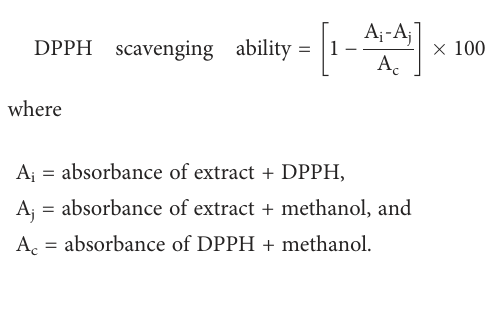
(using soil substrate) under fi eld conditions (Figure 8) supplemented with different concentrations of leachates